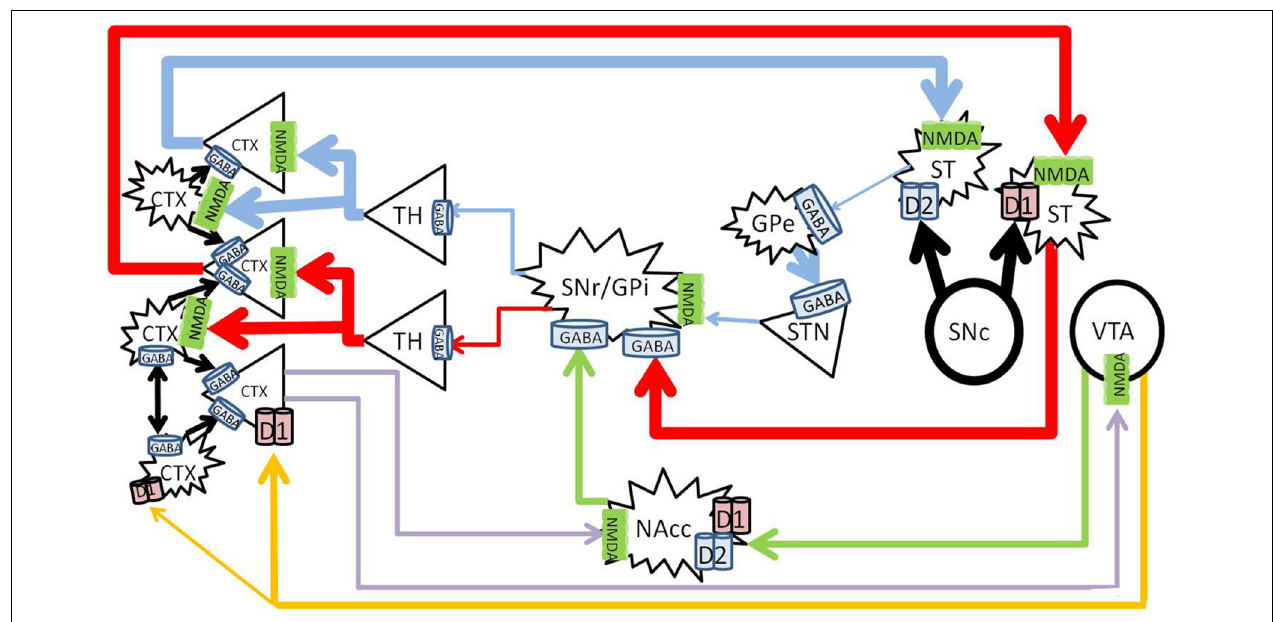
increases cortical pyramidal firing and simultaneously stimulates cortical interneurons, which sharpen the pyramidal signals to subcortical nuclei ( blue, red, and purple ). CTX, cortex; GABA, gamma-aminobutyric acid; NMDA, N-methyl-D-aspartate; GPe, globus pallidus externa; SNr, substantia nigra pars reticulata; GPi, globus pallidus interna; TH, thalamus; STN, sub thalamic nucleus; NAcc, nucleus accumbens core; VTA, ventral tegmental area. Round structures indicate dopamine cell bodies; star shaped structures indicate GABA cell bodies; triangular structures indicate glutamate cell